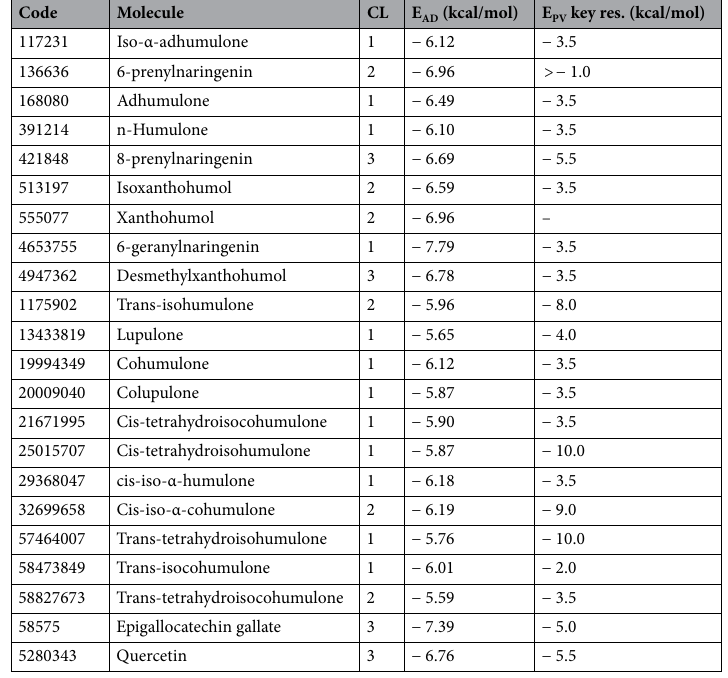
Table 1. Blind docking analysis of α and β-acids and prenylflavonoids against elastase. CL cluster number, AD AutoDock, PV PoseView. Employed software: AutoDock, PoseView.